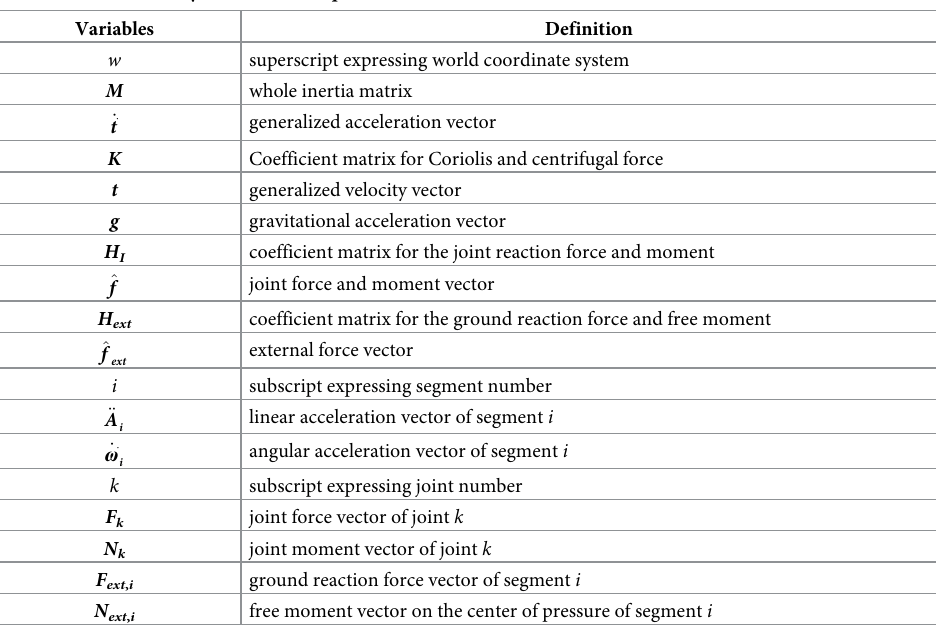
Table 1. Definition of symbols used in equations of